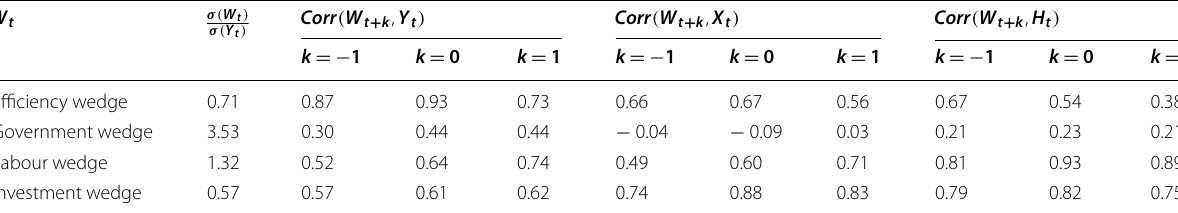
Table 8 Robustness: Wedge properties for ν = 2 (1980Q1–2016Q3)